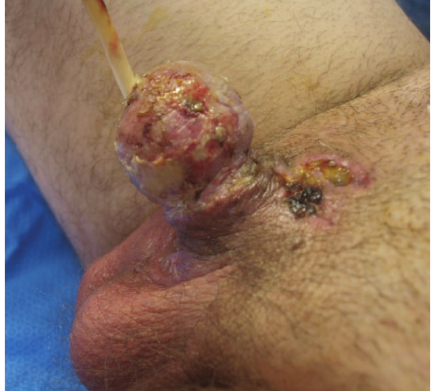
Figure 7: One week followup.